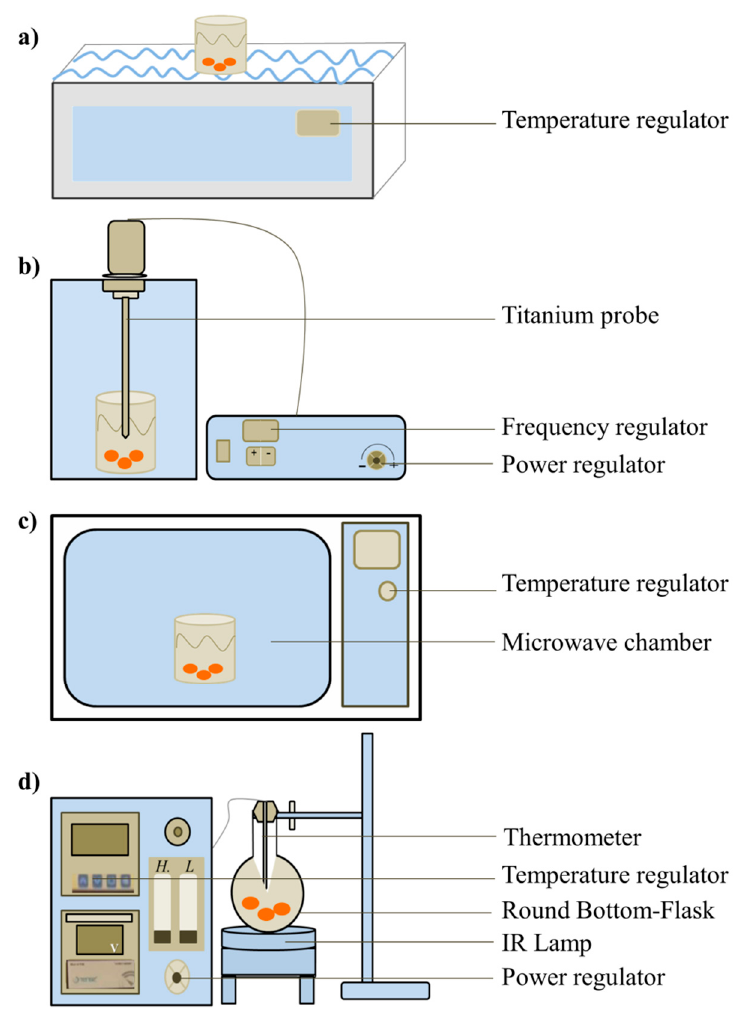
Figure 1. Instrumental set-up for the ( a ) solid-liquid, ( b ) ultrasound, ( c ) microwave, and ( d ) infrared methods.